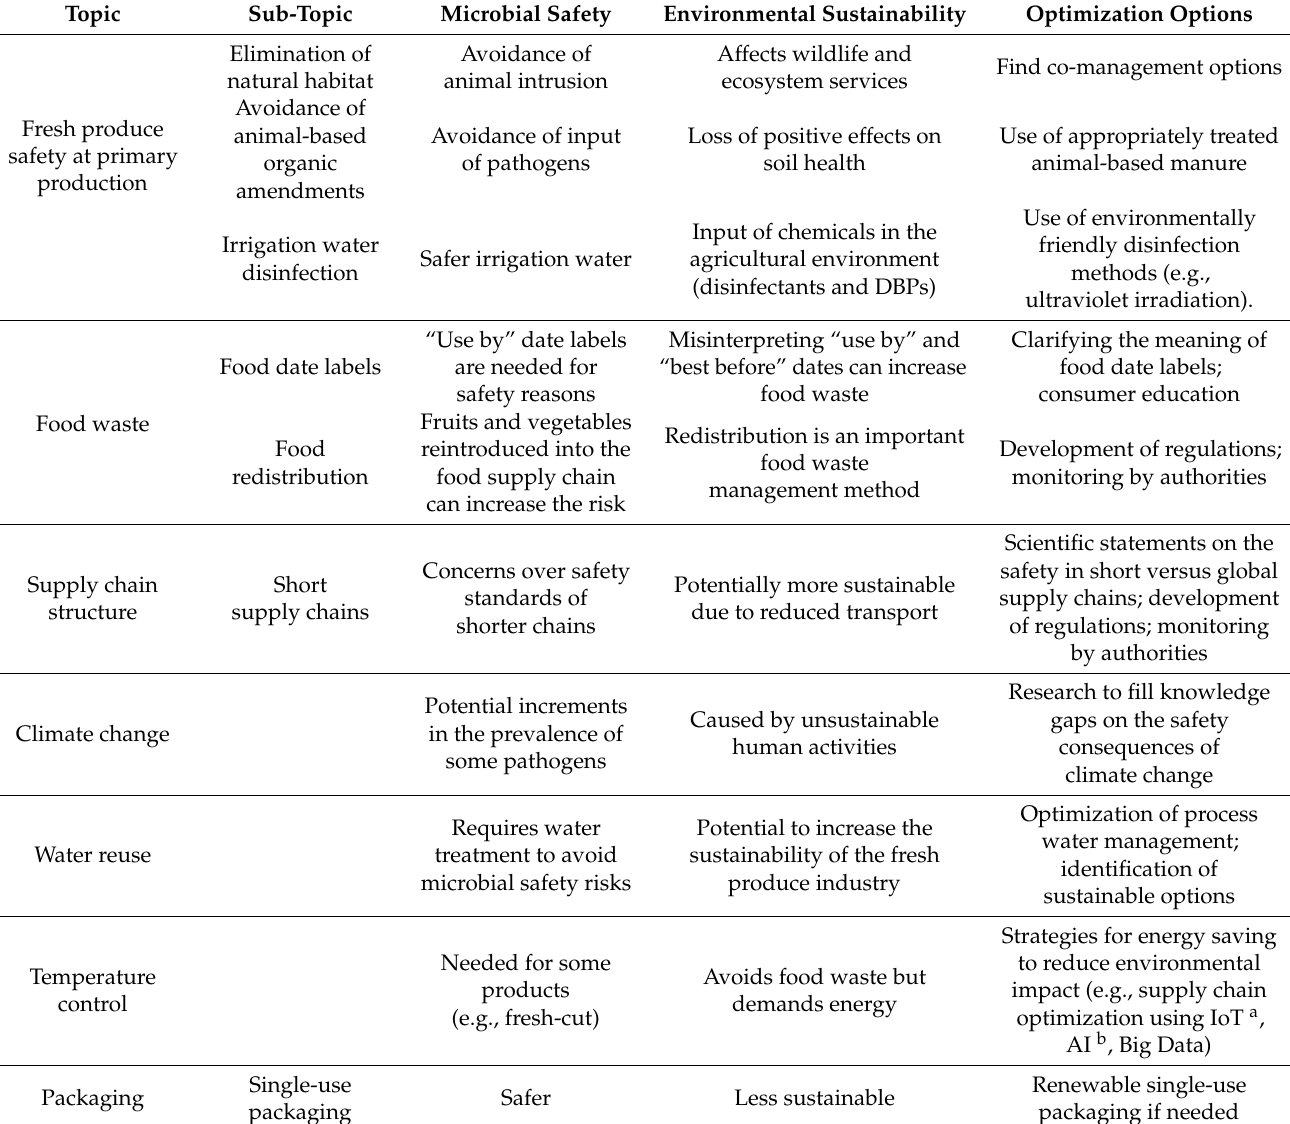
Table 1. Summary of topics covered, potential implications on fresh produce microbial safety and environmental sustain- ability discussed, and optimization